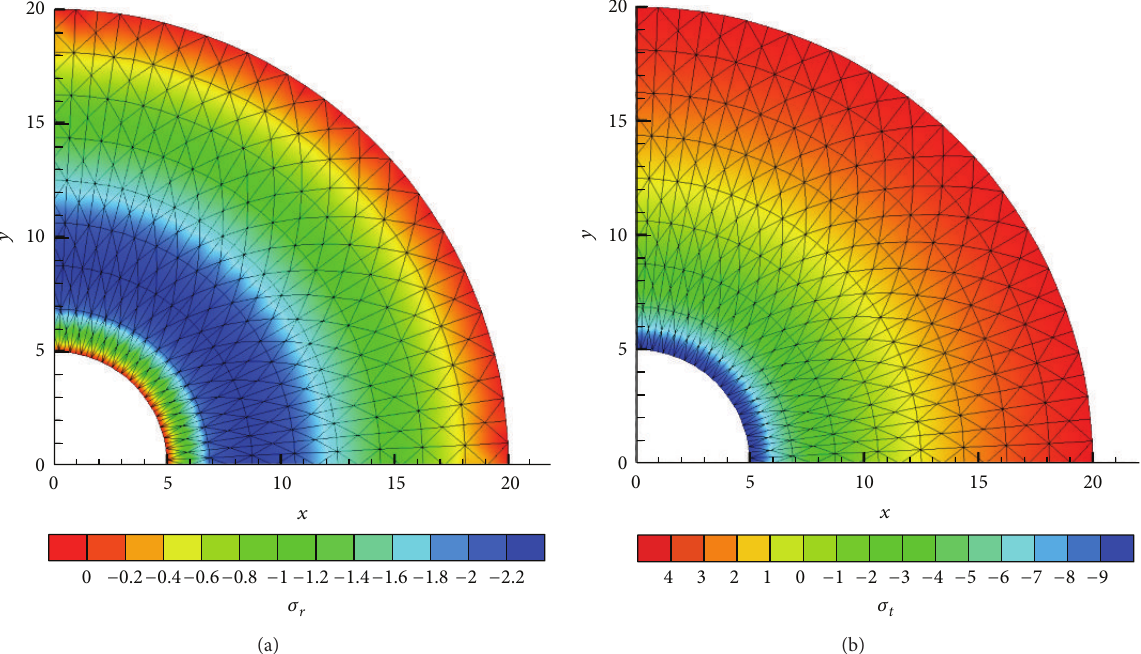
Figure 14: Contour plots of (a) radial and (b) circumferential thermal stresses (the background mesh in (a) and (b) is used for plots of the calculated results in